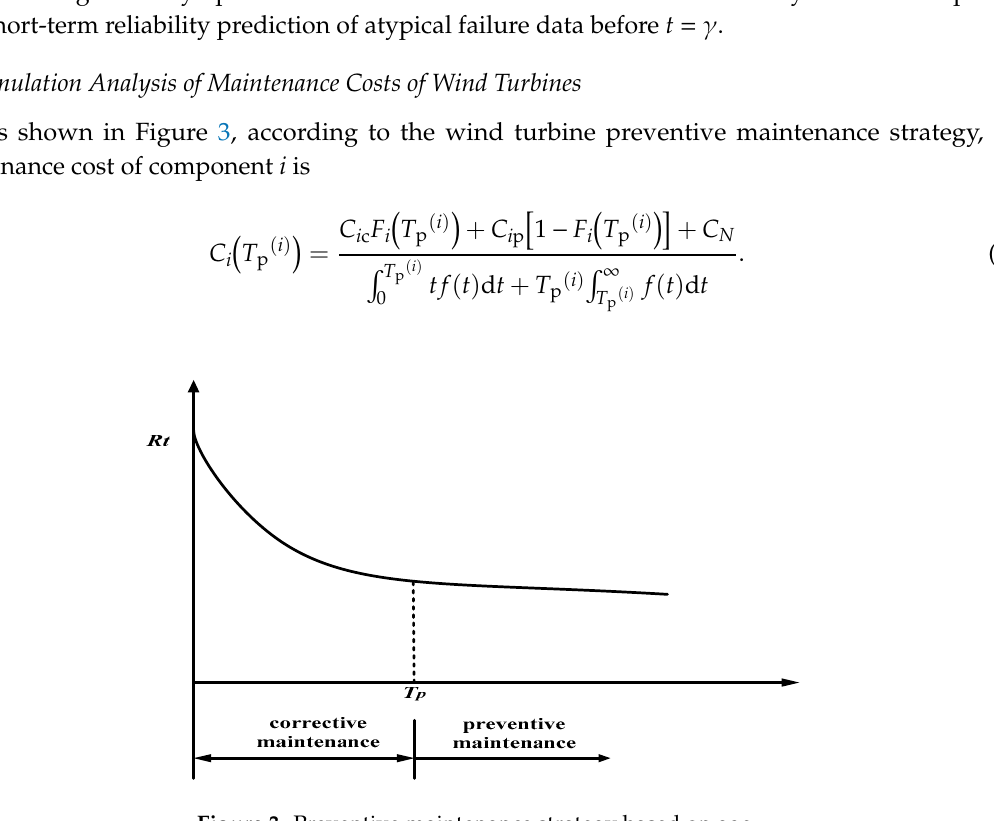
Figure 3. Preventive maintenance strategy based on age.